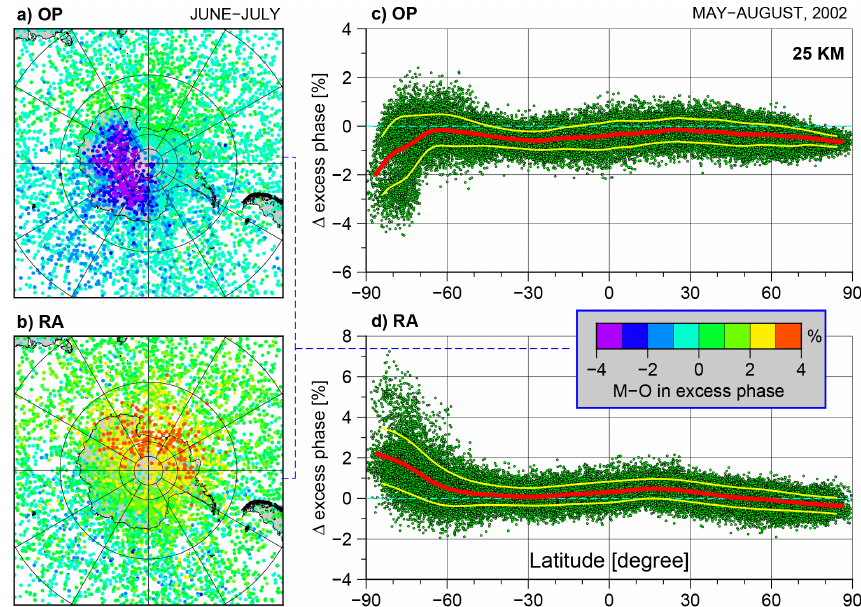
Figure 1. The percentage departure of ECMWF analyses from RO data in the excess phase at the height of 25km over the high southern latitudes for June–July, 2002: (a) operational (denoted OP) and (b) ERA40 (denoted RA) analyses. The latitudinal scatters of analyses minus RO (M–O) are shown for analyses of (c) OP and (d) RA, but for a 4-month period, May–August in 2002. The red solid curve is a piecewise second-order least-squares fit, and yellow curves indicate the envelope of 1 standard